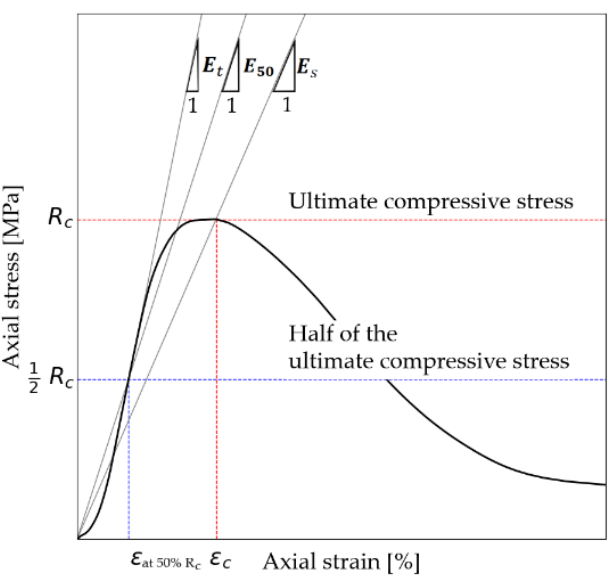
Figure 4. Analyzed elastic modules on the specimen before interpretation.